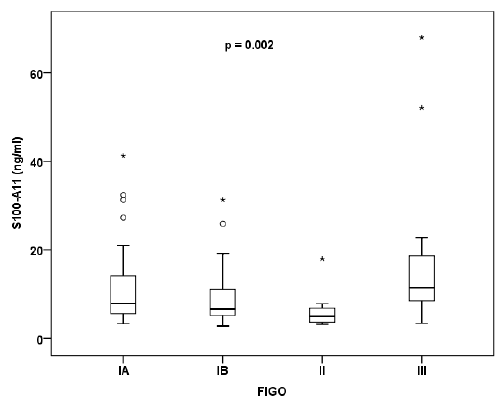
Figure 5: S100-A11 serum levels in endometrial cancer stage IA (IA, n=46), stage IB (IB, n=23), stage II (II, n=12), and stage III (III, n=17) patients.